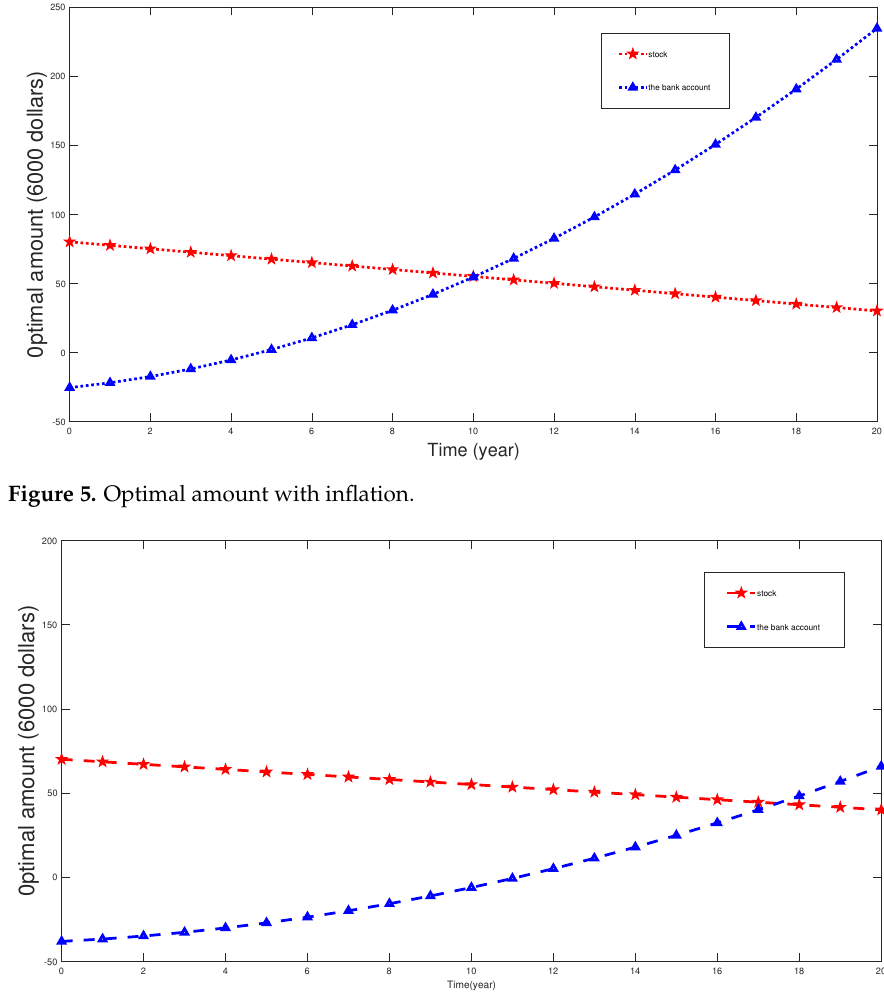
Figure 6. Optimal amount without